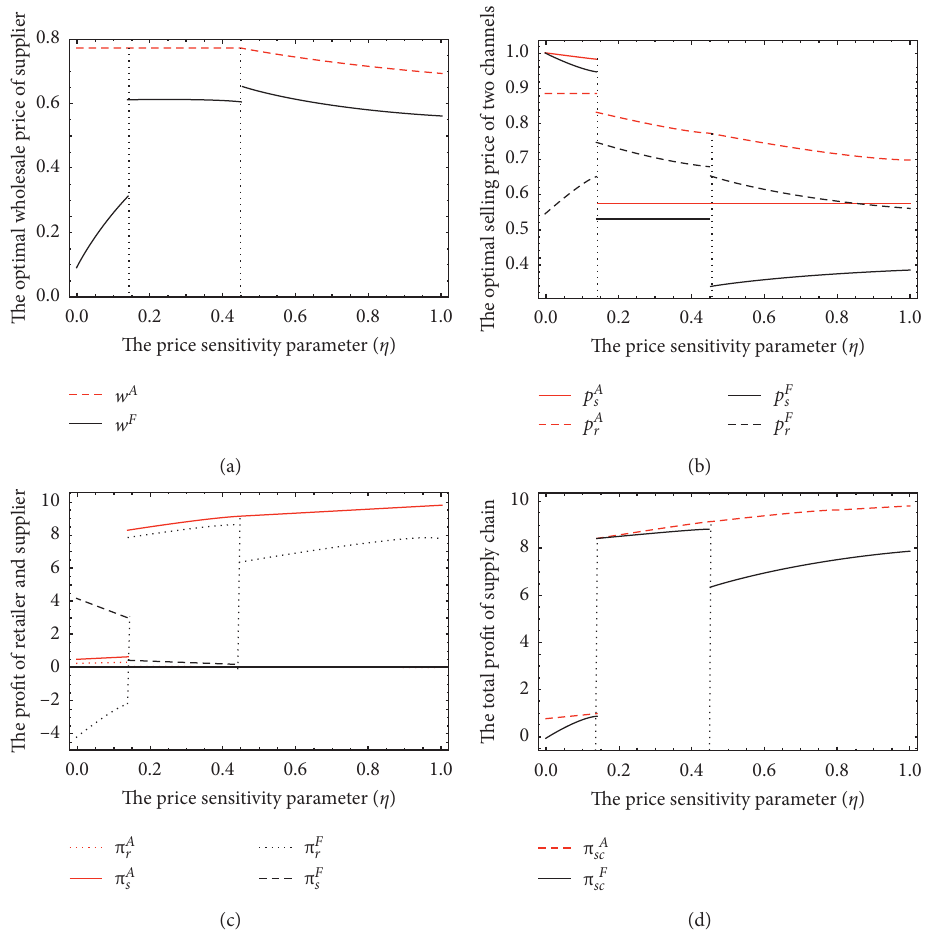
Figure 3: The impact of price-sensitivity parameter on decisions and profits. (a) The impact of η on wholesale price. (b) The impact of η on online price. (c) The impact of η on participants’ profits. (d) The impact of η on total profit of supply